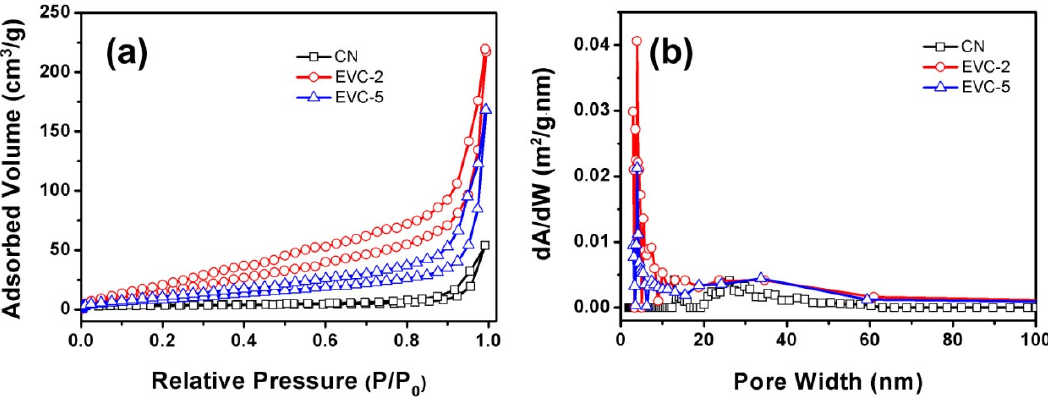
Figure 4. ( a ) The N 2 adsorption–desorption isotherms and ( b ) the corresponding BJH pore size distribution curves of CN, EVC-2, and EVC-5.